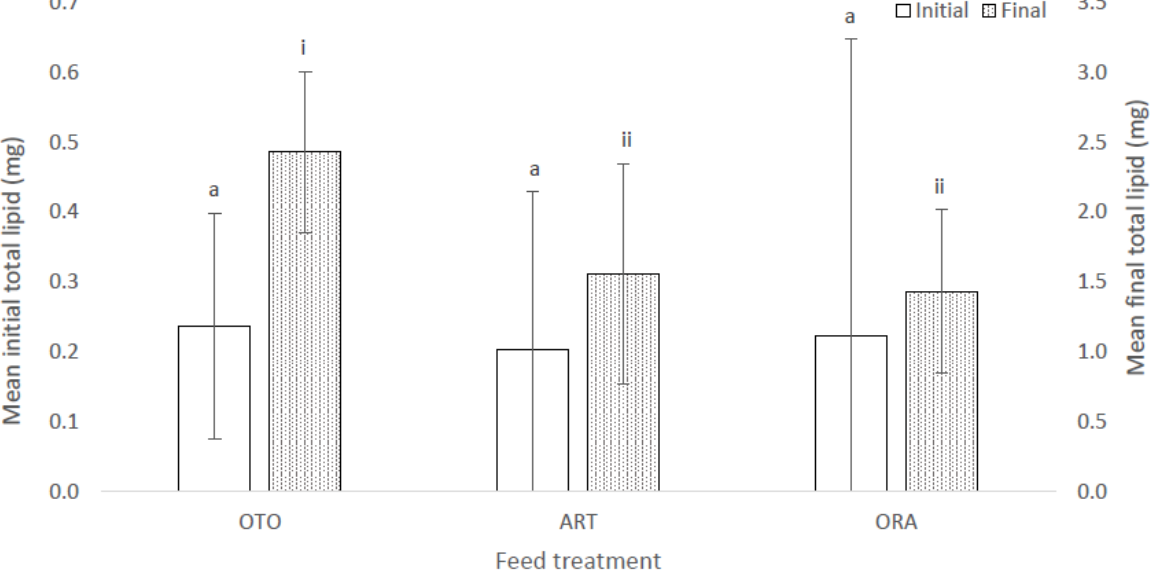
Figure 6. Mean initial and final total lipid for larval giant kōkopu in three different feed treatments; i.e., OTO (Otohime), ART (Artemac) and ORA (O.range) (mean ± SE). Means with different superscripts are significantly different within each of the set of three treatment means for each sampling event ( p < 0.05).